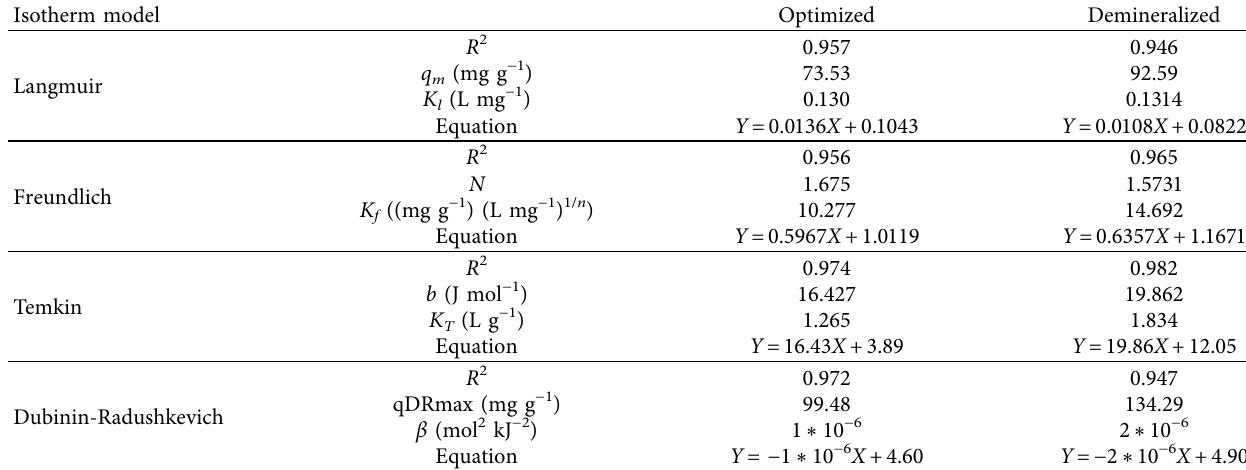
Table 5: Adsorption isotherm.